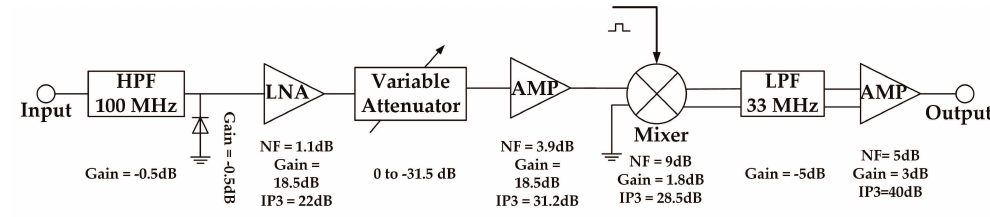
Figure 15. Link budget of the hardware